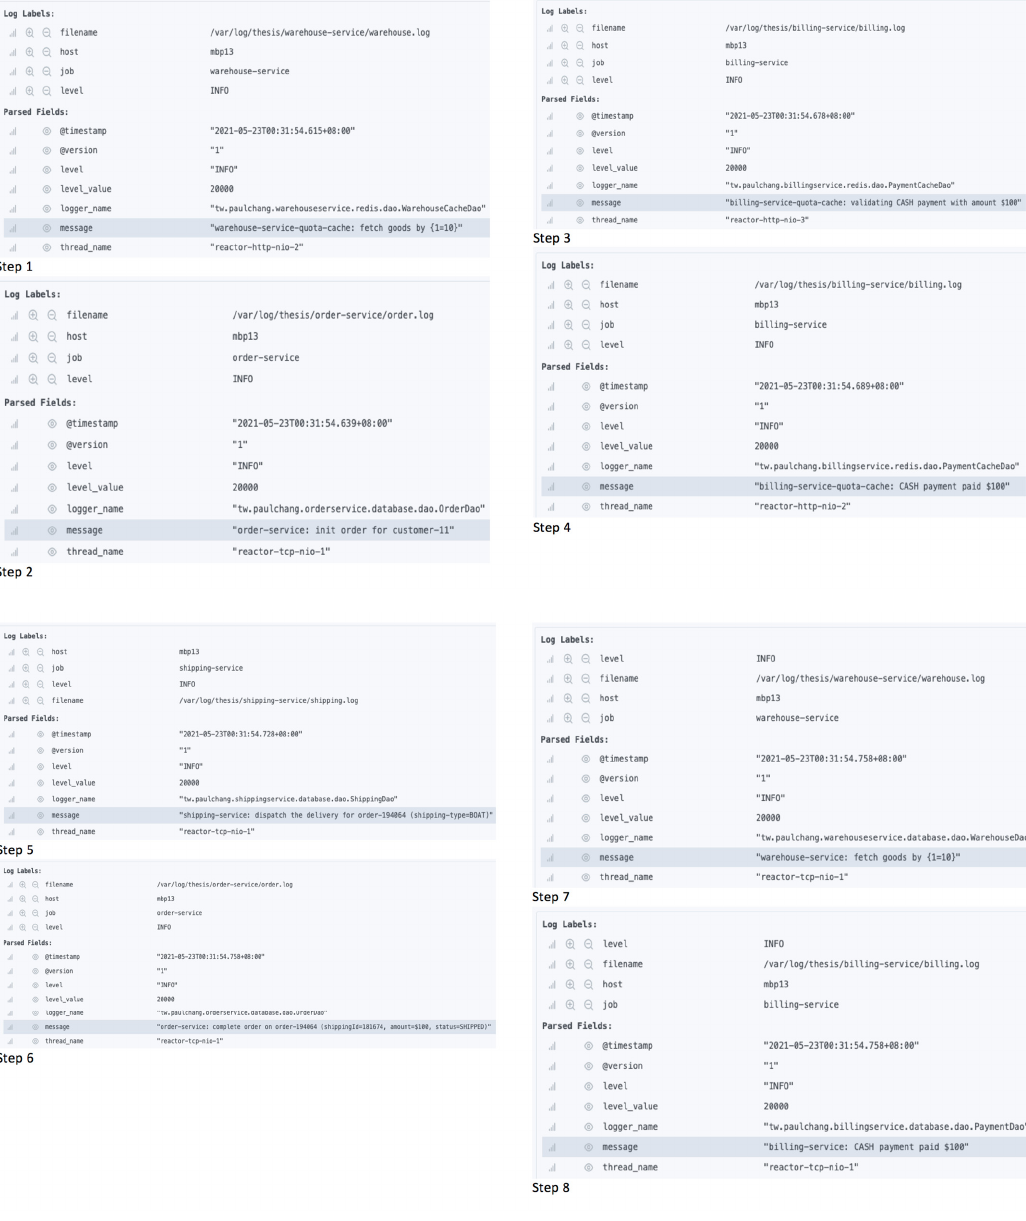
Figure 9. The Steps performed by version 2 (deploying enhanced saga pattern).